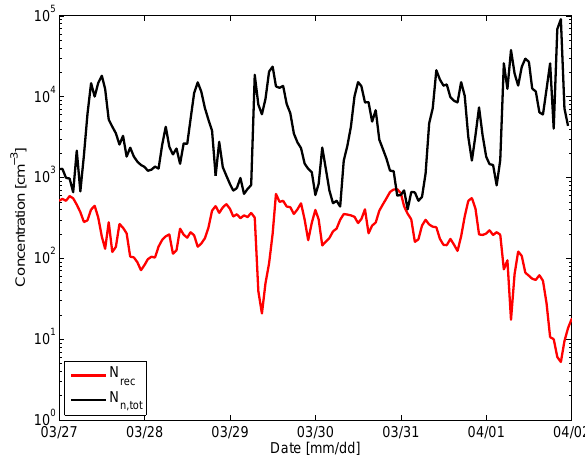
Fig. 4. The concentrations of recombination products ( N rec ) and all neutral clusters ( N n , tot ) in the size range of 0.9–2.1nm during the period 27 March–1 April 2011. The recombination product concen- tration exceeded the concentration of all neutral clusters briefly on 30 March because the total neutral cluster concentration data did not cover the whole size range at that